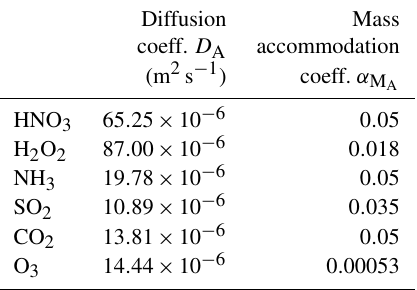
Table C4. Diffusion constants (Massman, 1998; Tang et al., 2014) and accommodation coefficients (Kreidenweis et al., 2003) for relevant chemical compounds.